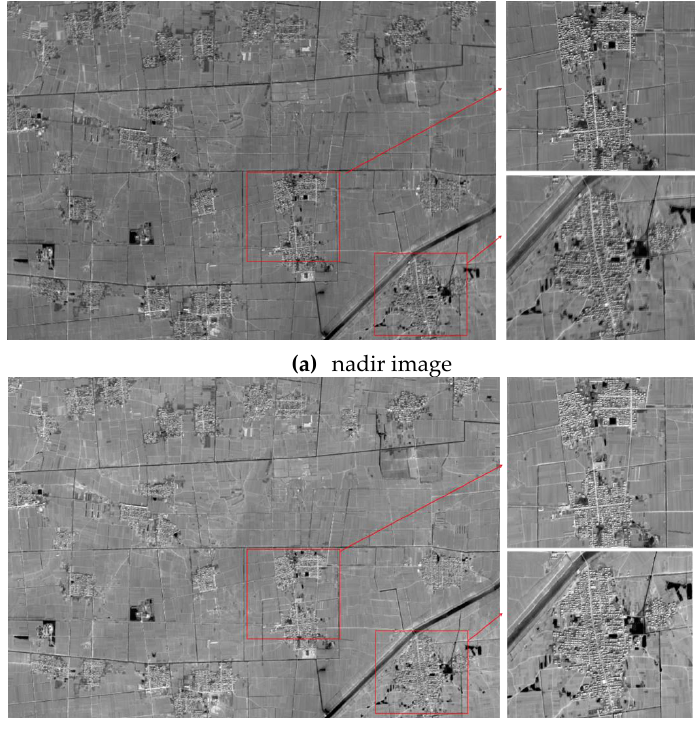
Figure 2. Experimental ZY-3 TLC nadir images and super resolution images. ( a ) is the original nadir image with partial enlarged views. ( b ) is the corresponding super resolution image with partial enlarged views. For better comparison, we display the nadir image and super-resolution (SR) image in the same scale.